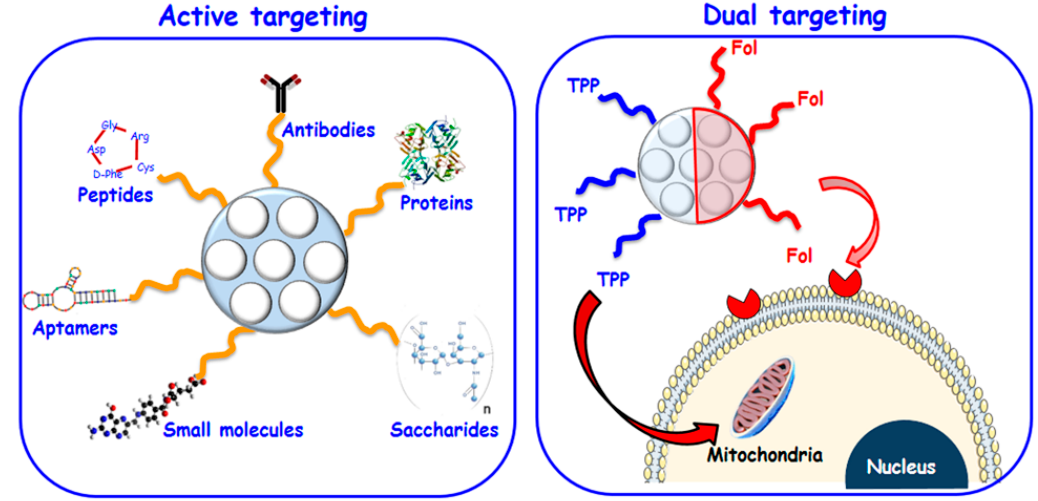
Figure 2. ( Left ) Schematic depiction of active targeting possibilities on MSNs; ( Right ) Dual targeting strategy to target both cell membrane of tumor cells and mitochondria by asymmetrically functionalized nanoparticles (J-MSNs).